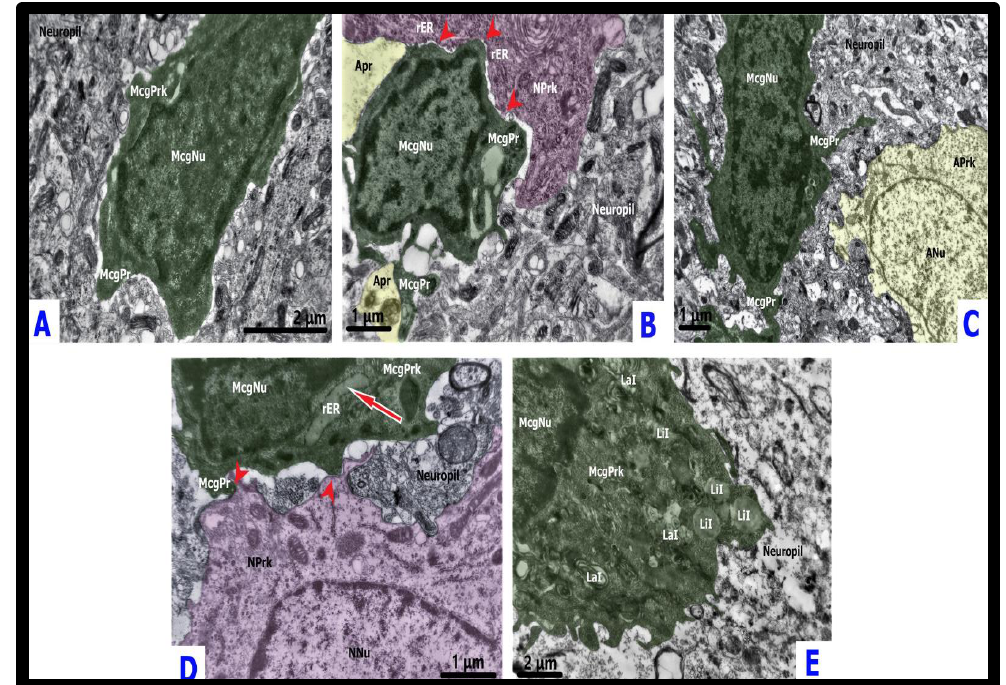
Figure 3. Ultrastructure of surveilling and reactive microglia. Panel ( A ) demonstrates the ultra- structure of the control model surveilling microglia (green). The elongated cell body with main cytoplasmic processes emanating from the body pole, as well as smaller lamellipodia; osmiophilic cytoplasm and karyoplasm from the cortex of a control rat (CLP-C group 48 h after procedure). Panel ( B ) depicts the amoeboid microgliocyte (green) that formed direct contacts (red arrowheads) with neu- rons (pseudo-colored dark-pink) with ischemic condensation, and parenchymal astroglial processes (pseudo-colored yellow). Formation of dotted junctions at sites where microglial somatic protrusions invaded neuronal perikaryon; multiple microglial filopodia enwrapping disorganized neuropil com- ponents on the opposite pole of cell body. Neuronal perikaryon close to microglial-somatic junctions was enriched with rough endoplasmic reticulum (ER)-plasma membrane contacts, vacuole- and lysosomes-like structures, Golgi apparatus membranes. Tight attachment of microglial and astroglial plasmalemmas. Dilated free spaces around thin microglial processes. The cortex of a survived rat (CLP-A group 48 h after the CLP procedure). Panel ( C ) depicts a rod-like microgliocyte (green) directing its processes toward a partially degenerated astrocytic body (pseudo-colored yellow) in the cortex of a survived rat (AILF-A group). Accumulation of mitochondria in astroglial perikaryon close to plasma membrane facing nearby microglia (24 h after the procedure). Panel ( D ) depicts the close approximation of the hypertrophic-like (green) microgliocyte to the neuron (pseudo-colored pink) with slight swelling. Formation of dotted connections (red arrowheads) between cells by microglial cy- toplasmic protrusions (lamellipodia) extended towards neuronal perikaryal prominences. Neuronal perikaryon close to the microglial–somatic junctions was enriched with mitochondria, rough ER- plasma membrane contacts, free ribosomes, and a group of small electron-dense granules. Microglial satellite showed widened rough ER (red arrow). Lamellipodia were surrounded by dilated pockets of extracellular space. The cortex of a survived rat (CLP-A group, 48 h after the CLP procedure). Panel ( E ) depicts gitter cell-like microglia (green) at the border zone between the cortex and white matter of a non-survived rat (CLP-B group 38 h after the CLP procedure). The enlarged cytoplasmic volume displayed an accumulation of lipid and complex lamellar inclusions, lipofuscin-like granules, and residual bodies. Note the appearance of numerous lamellipodia and filopodia located toward